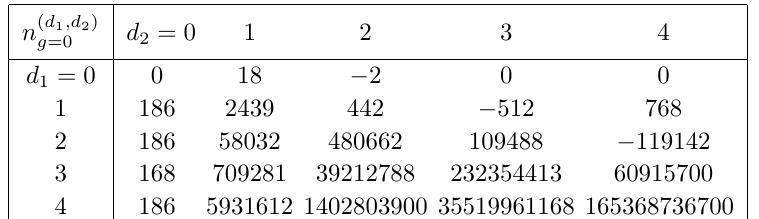
Table 4 . Genus 0 GV-invariants associated to X (1)